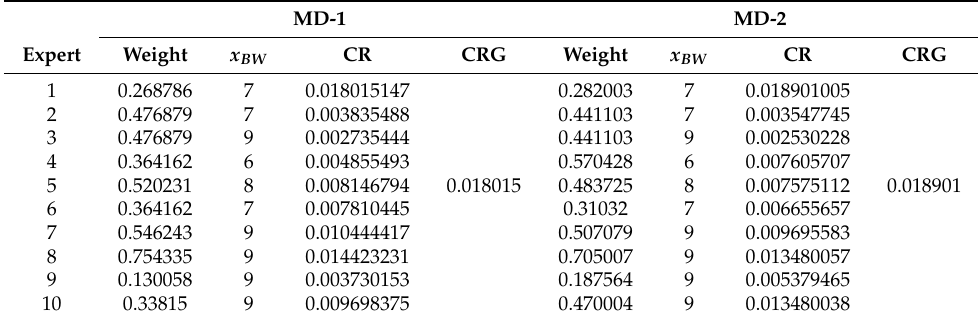
Table 13. Result of case study for MD-1, and